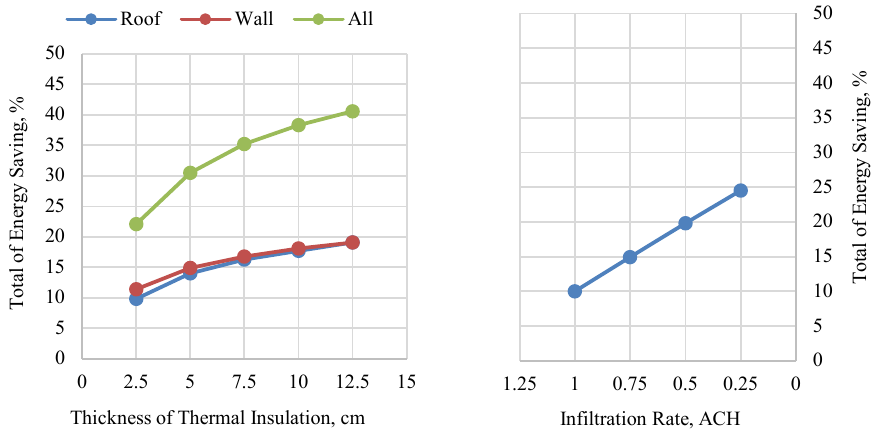
Fig. 8. Annual energy saving present from insulation (left) and infiltration rate (right) in climate zone 4. The final results show that in different climates the reduction of infiltration to half (0.75 air changes per hour (ACH)) shows a similar potential to reduce energy demand as 10 or 12.5 cm roof or wall insulation. Also, the reduction of infiltration rate to a low level (0.25 ACH) can decrease energy demand more effectively than 12.5 cm insulation in the roof or